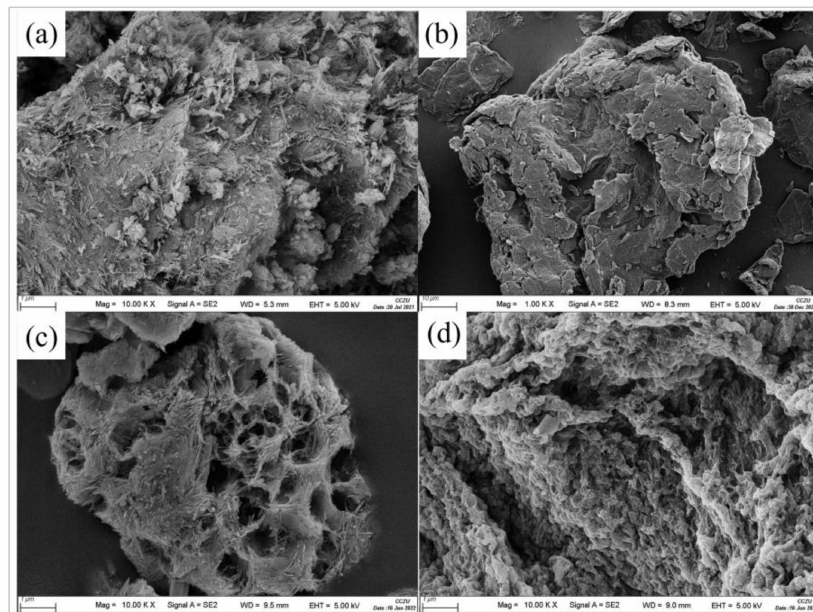
Figure 2. SEM images of ATP ( a ), GO ( b ), GO − ATP ( c ) and GO − ATP@CS − PVA ( d